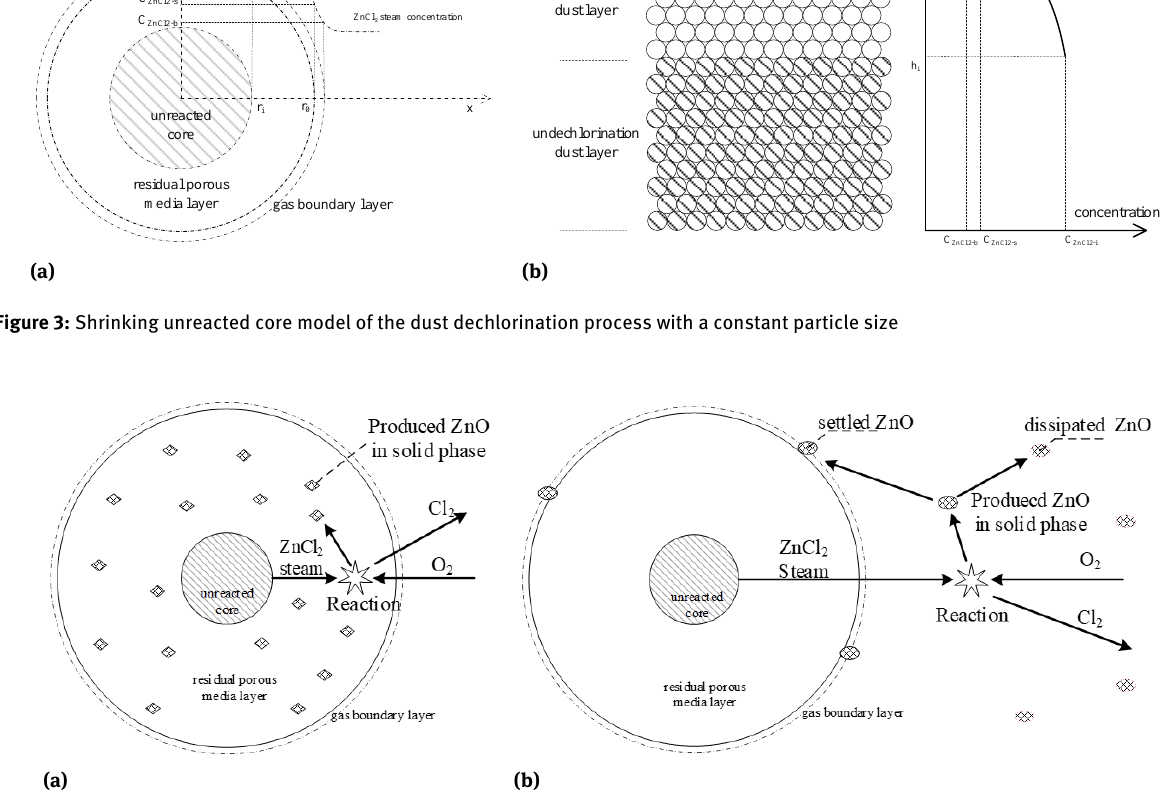
Figure 4: Hypotheses about the dechlorination and [Zn] reclaiming reactive